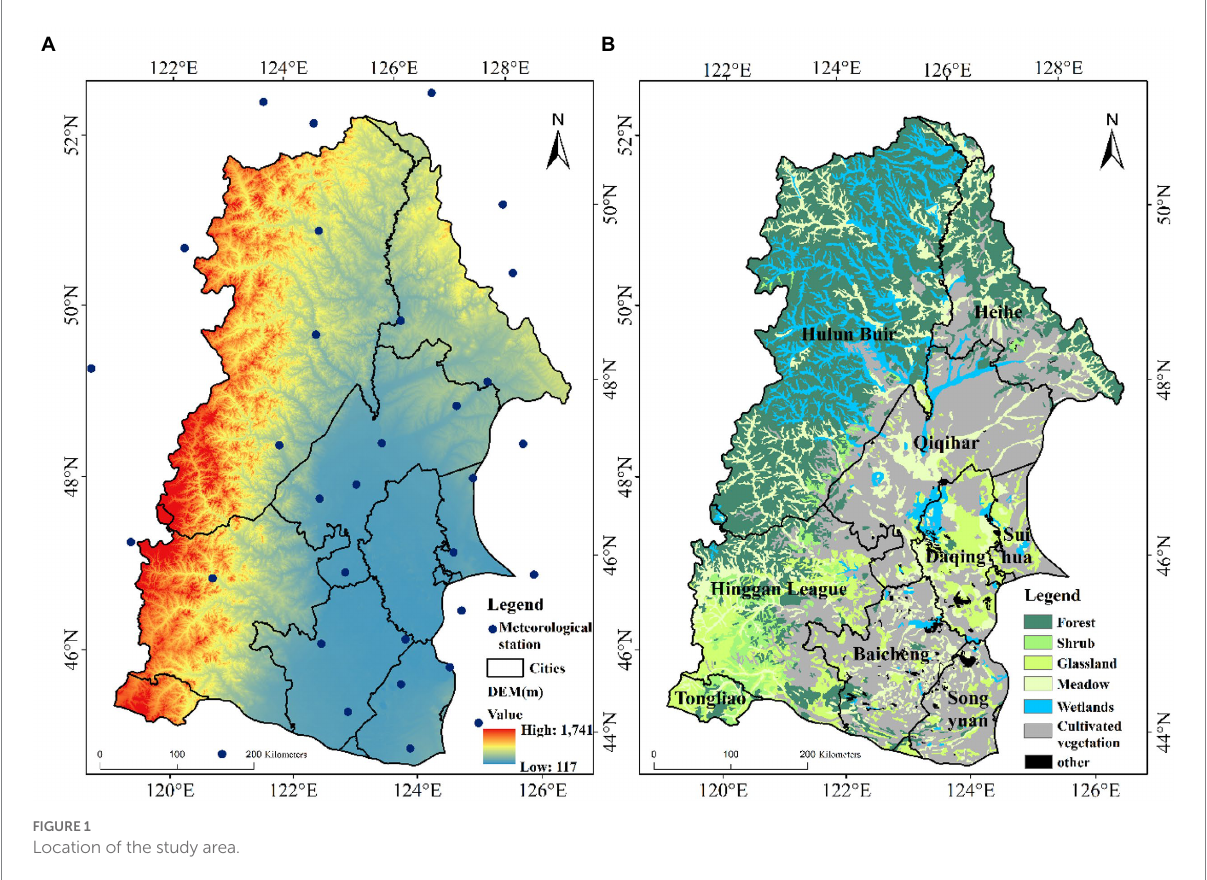
FIGURE 1 Location of the study